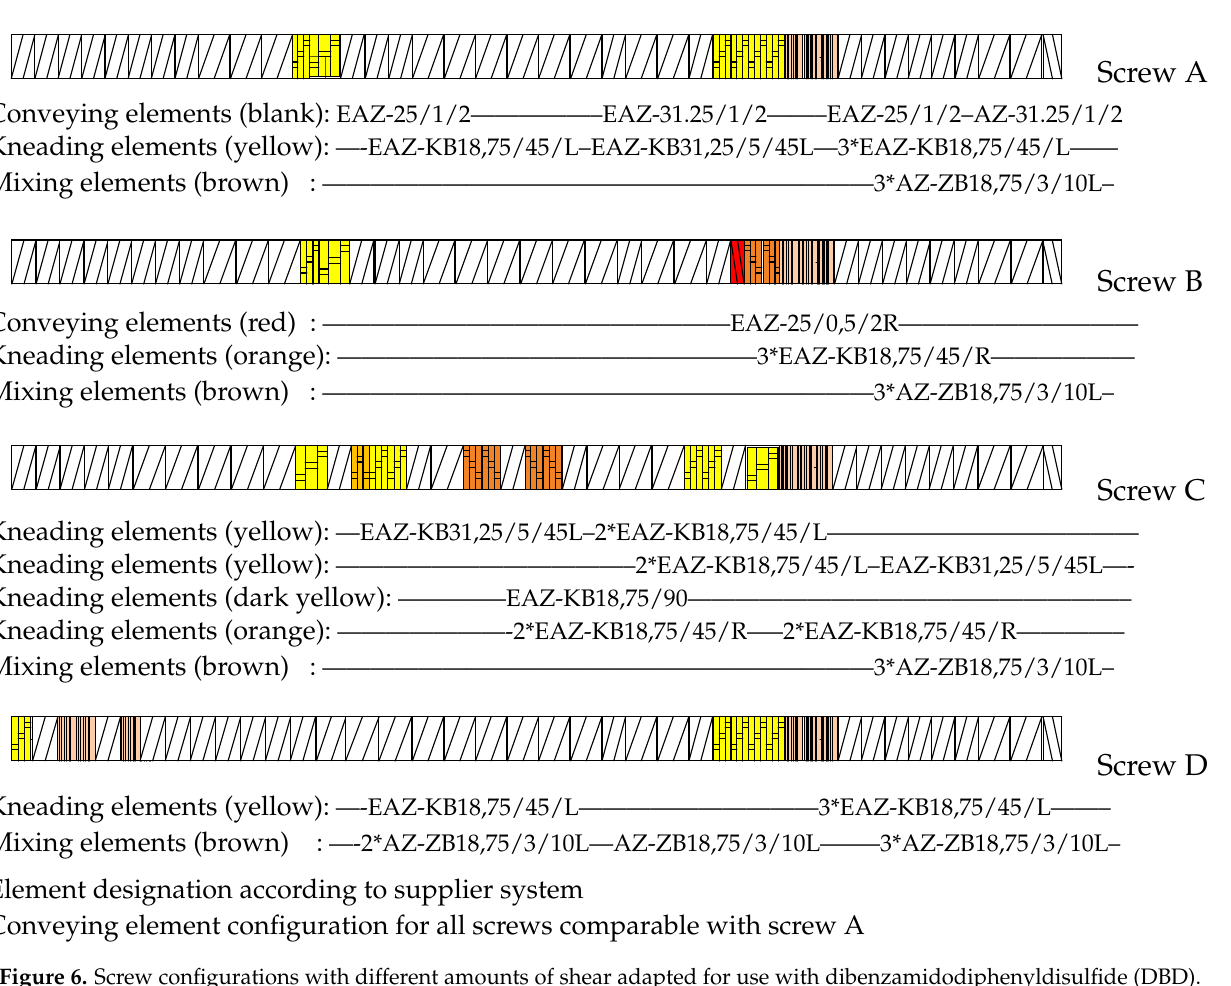
Figure 6. Screw configurations with different amounts of shear adapted for use with DBD.